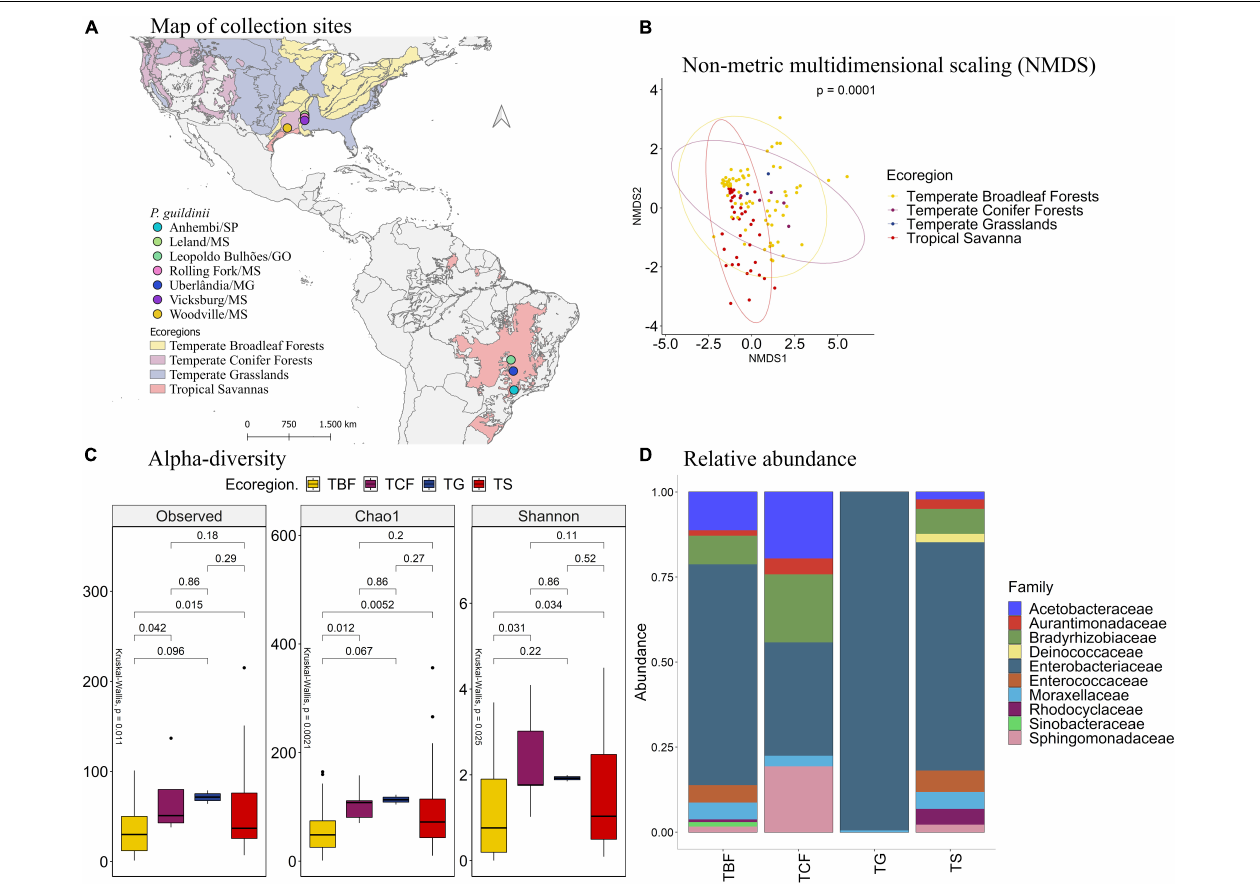
FIGURE 3 | (A) Mapping of collection sites of P. guildinii , classified by ecoregion in Brazil and the United States. (B) NMDS of Bray-Curtis similarity matrix among 117 samples from the intestinal microbiome of P. guildinii , for the different ecoregions from Brazil and United States. The ellipses are showing clustering between ecoregions. Permutational multivariate analysis of variance (PERMANOVA) is indicated in the upper right. (C) Alpha diversity levels based on Observed OTU, Chao1 index and Shannon index for the different ecoregion. The non-parametric test (Kruskal–Wallis) is indicated in the upper left of each graph. Pairwise comparison (Wilcoxon) is indicated between Ecoregions. (D) Analysis of the ten most abundant bacteria families in the intestinal microbiome of P. guildinii collected in Brazil and the United States, classified by